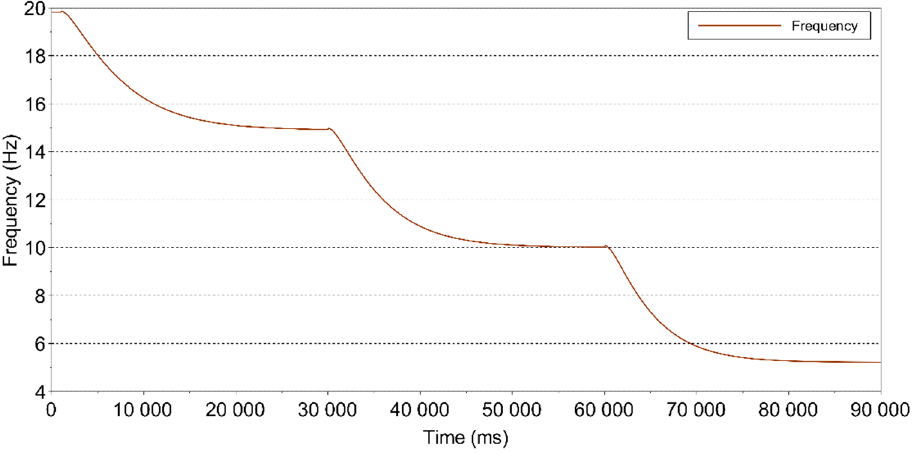
Figure 8. Frequency at the inverter output.